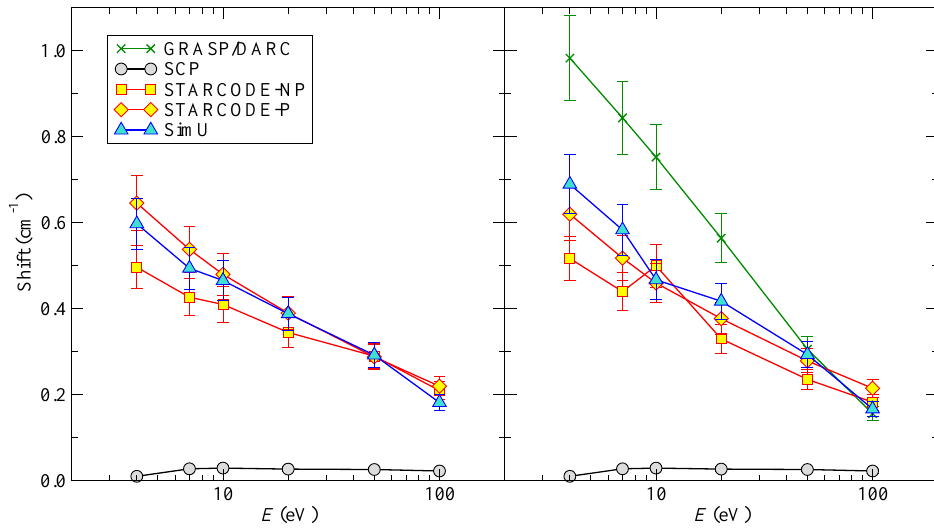
Figure 9. B III 2 s − 2 p shift as a function of the energy E . ( Left ) only the dipole interaction is taken into account; ( Right ) the dipole and quadrupole interaction are both taken into account.